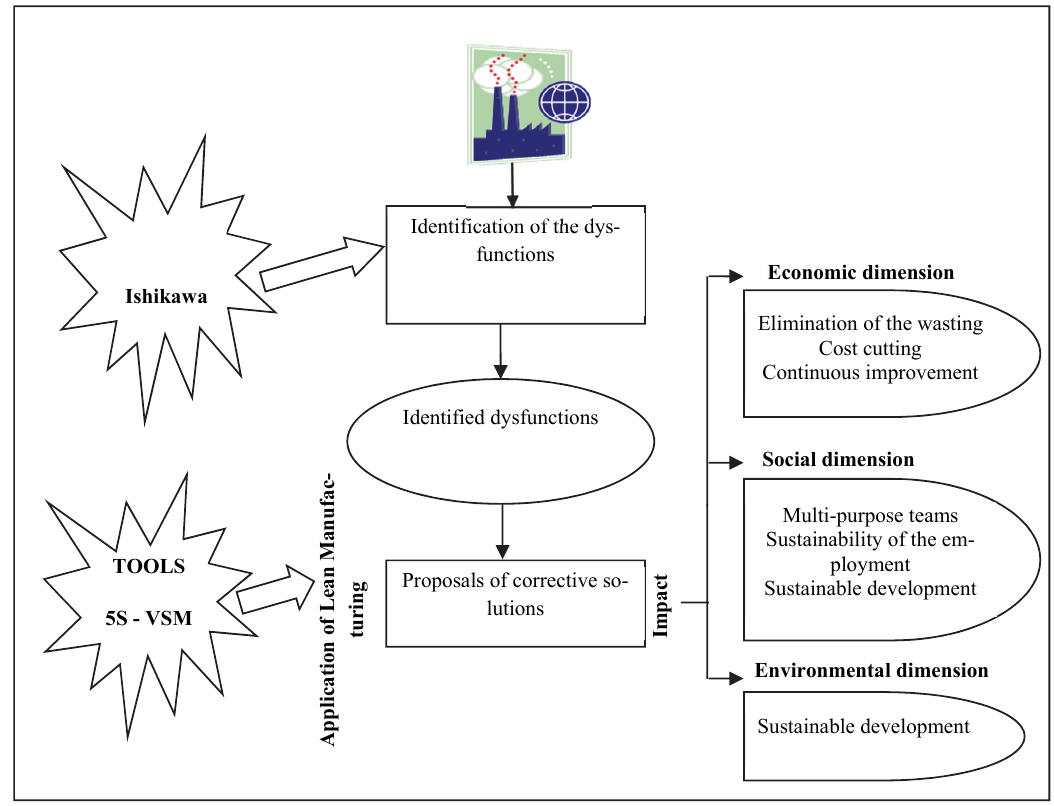
Fig. 1. Architecture of the proposed model for continuous